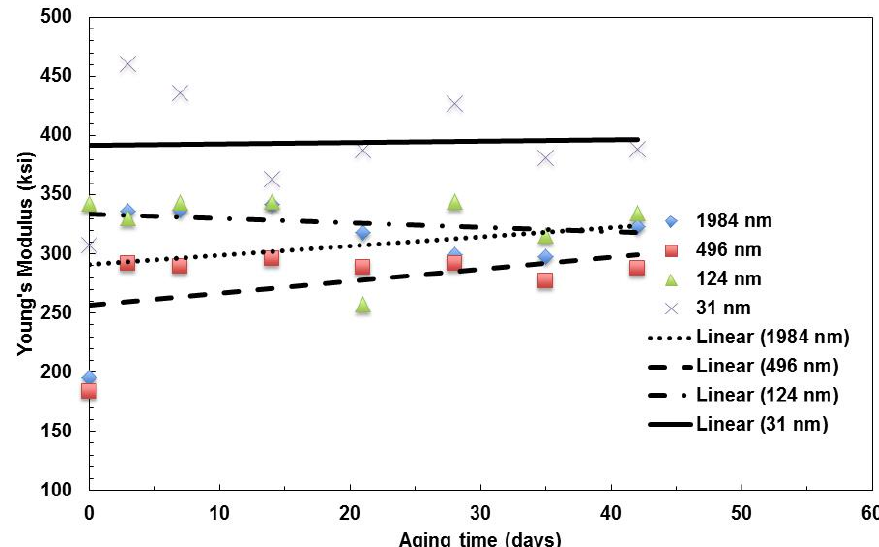
Figure 2. Summary of the change in Young’s modulus with aging time for films with various layer thicknesses aged at 100